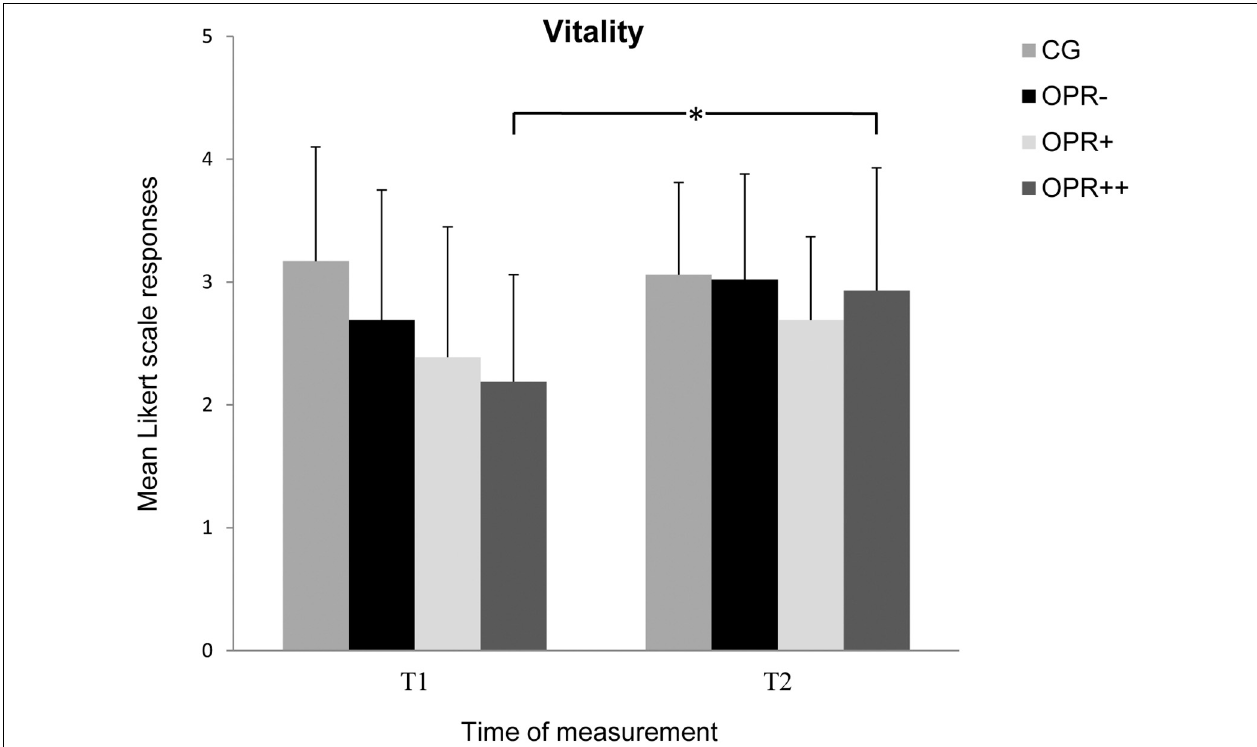
FIGURE 1 | The mean values of the Vitality of the groups as a function of the time of measurement (T1, T2). The symbols represent across-participant means, and error bars show standard deviations. The 6-point Likert scale ranged from “does not apply at all” (0) to “fully applies” (5). (CG: control group without any intervention; OPR - group: got an empty bottle for filling without any label on it; OPR + group: got an empty bottle for filling with the label “Imagine I Am Health”; OPR ++ group: got an empty bottle for filling with the label “Imagine I Am Health” and an audio file with a health mediation) (*p < 0.013).